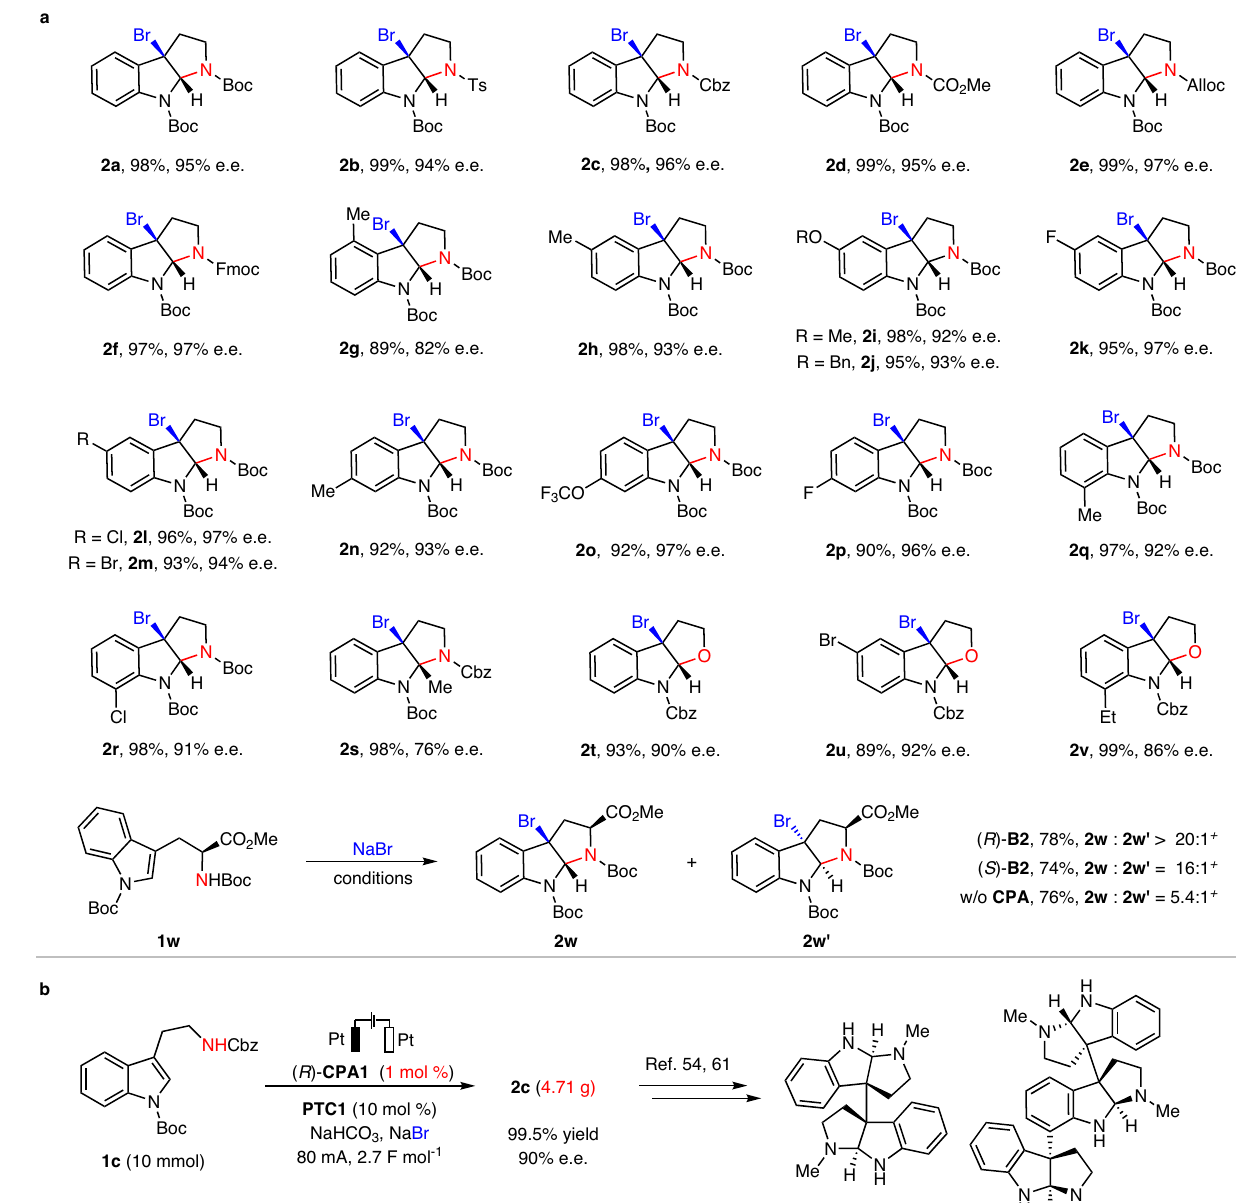
Fig. 2 | Evaluation ofscope and application of the electrocatalytic asymmetric bromocyclization of tryptamine and tryptophol derivatives. a Reaction scope regarding the tryptamine and tryptophol derivatives. 1 (0.3mmol), ( R )- CPA1 (5mol %), PTC1 (10mol %), NaHCO 3 (0.1M in H 2 O), NaBr (1M in H 2 O), toluene (6mL), H 2 O (5mL), Pt anode and cathode (10mm×10mm×0.2mm), stirring speed: 1000r/min, 4mA (2.5 – 3.0Fmol − 1 ), rt. Isolated yields were provided, and